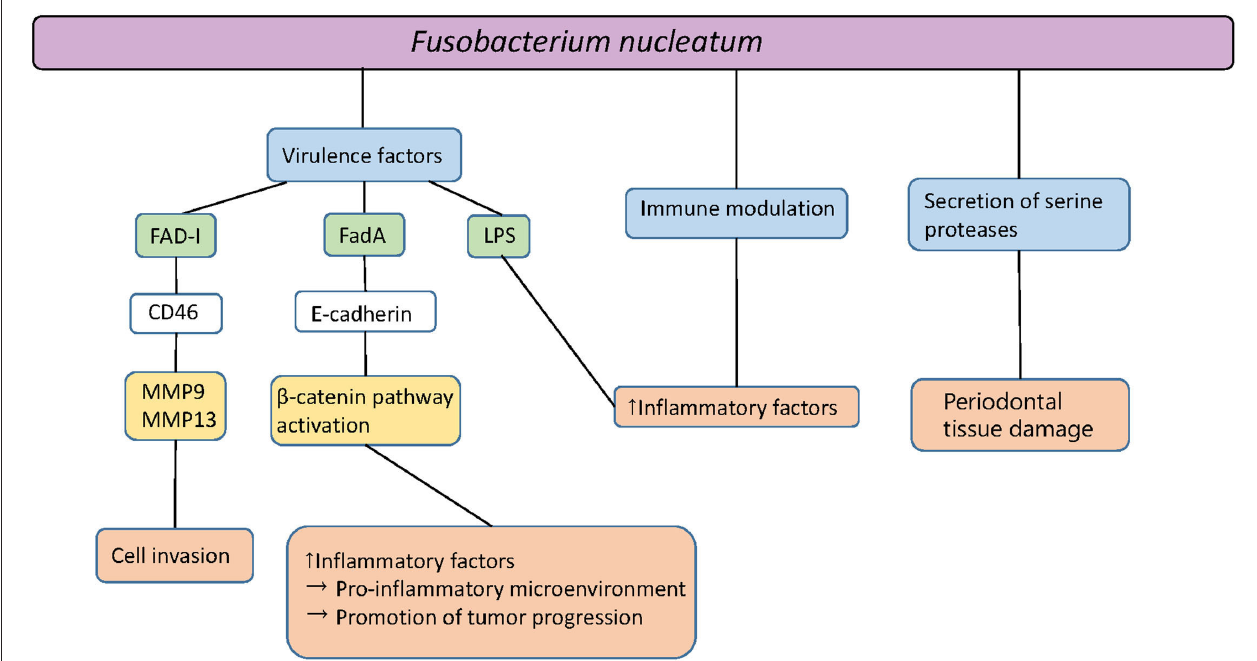
FIGURE 1 | Pathogenicity of Fusobacterium nucleatum . Fad-I, Fusobacterium -associated defensing inducer; FadA, Fusobacterial adhesion; MMP, Matrix metalloproteinase; LPS,